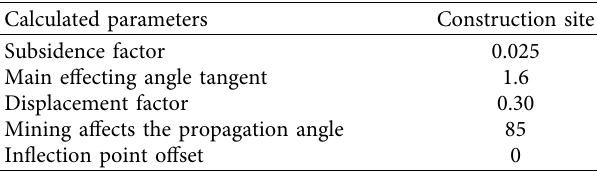
Figure 9: Images of the J1 detection borehole. Table 7: Parameters of surface movement after